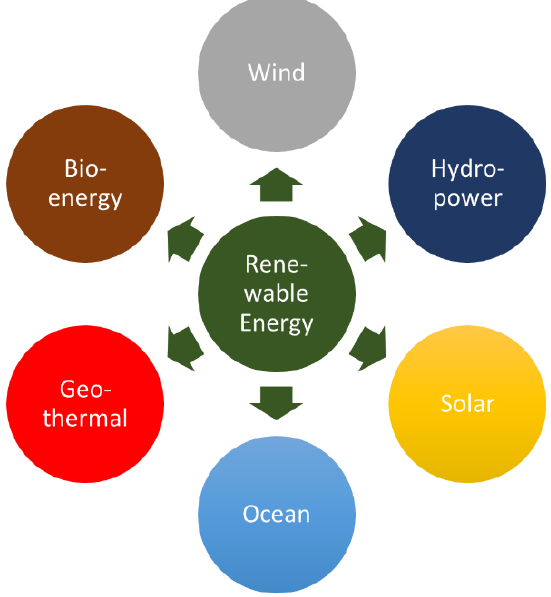
Figure 1. Types of renewable energy. Source: own study based on [11].